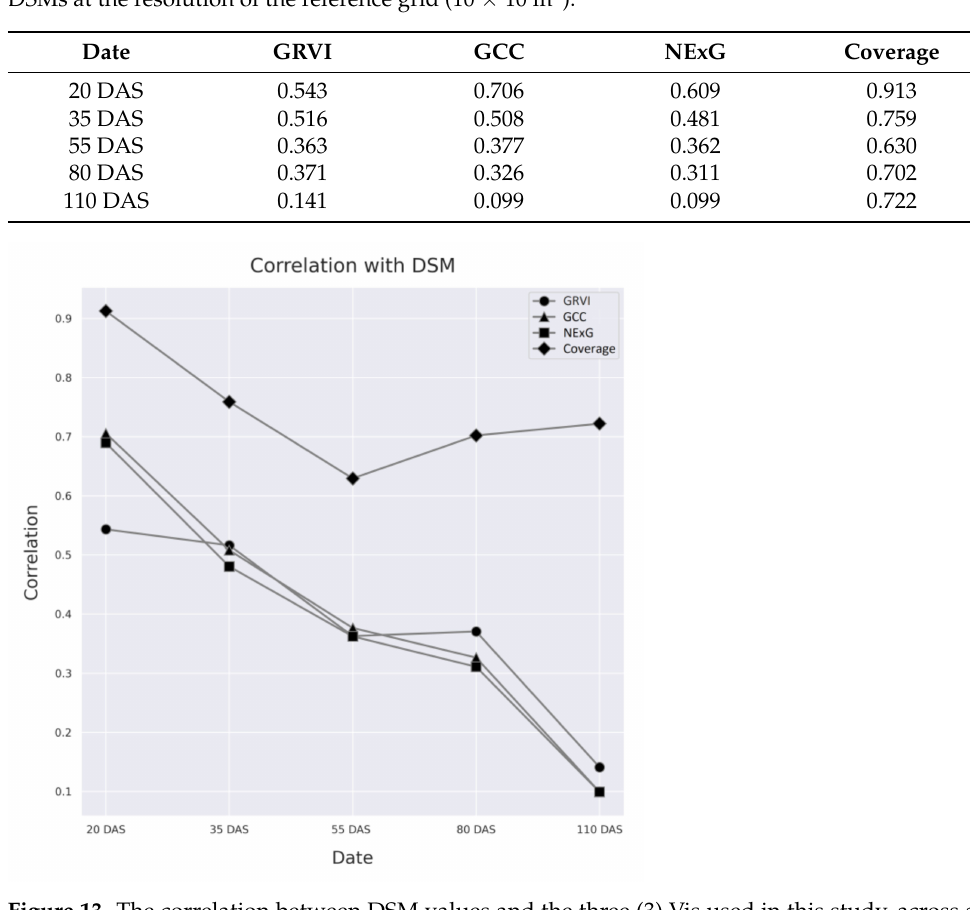
Figure 13. The correlation between DSM values and the three (3) Vis used in this study, across all data collection